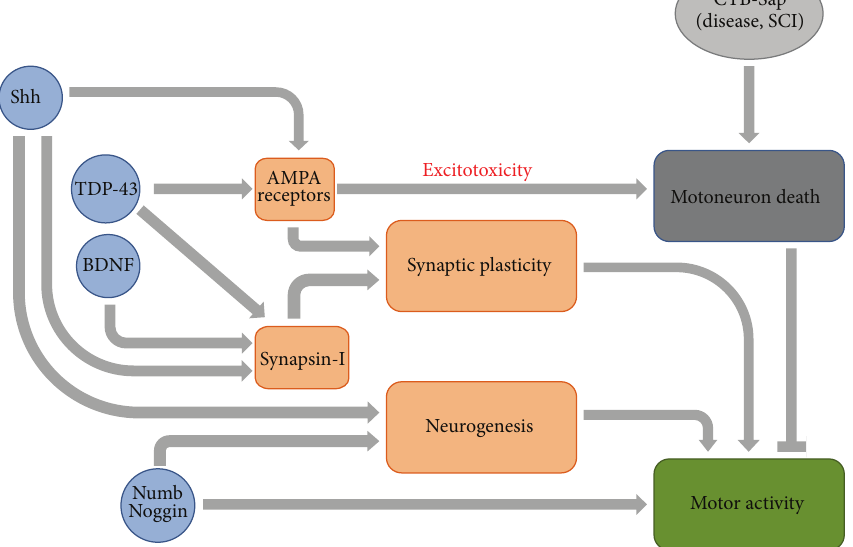
Figure 1: Proposed model of spontaneous SC plasticity after motoneuron